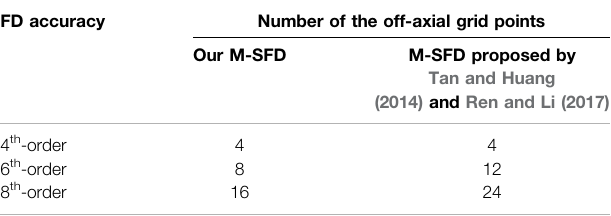
TABLE 1 | Number of the off-axial grid points required by our M-SFD and the previous M-SFD to make the FD discrete acoustic wave equation reach speci fi ed order